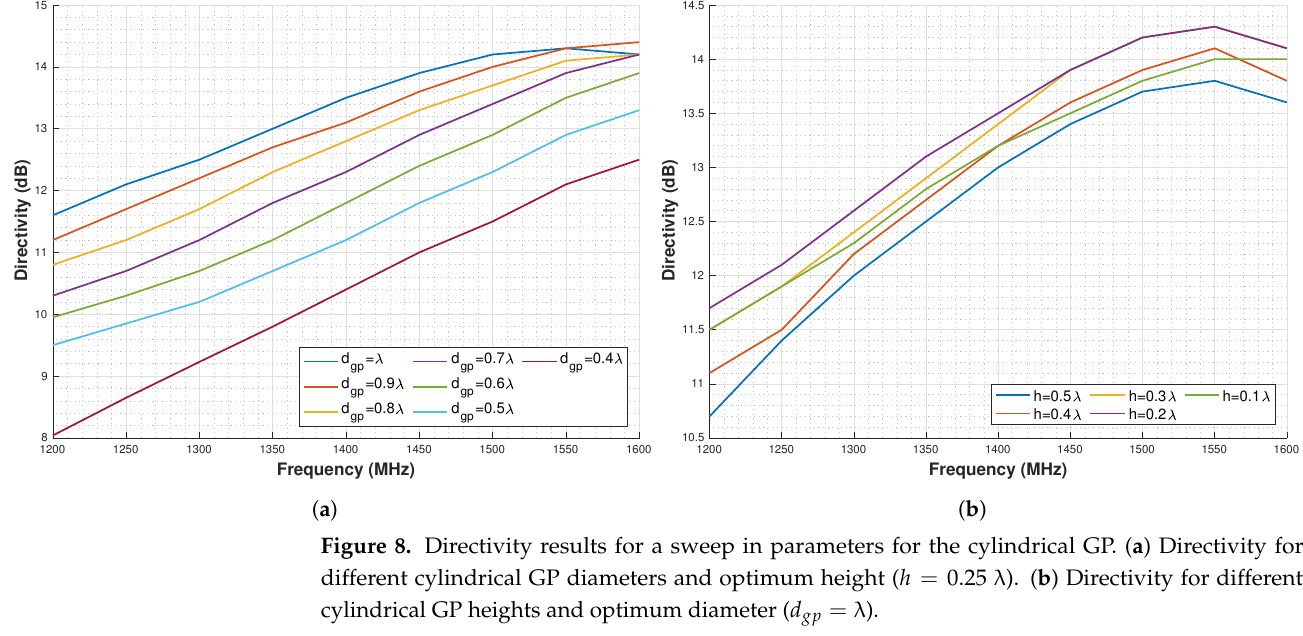
Figure 8. Directivity results for a sweep in parameters for the cylindrical GP. ( a ) Directivity for different cylindrical GP diameters and optimum height ( h = 0.25 λ ). ( b ) Directivity for different cylindrical GP heights and optimum diameter ( d gp = λ